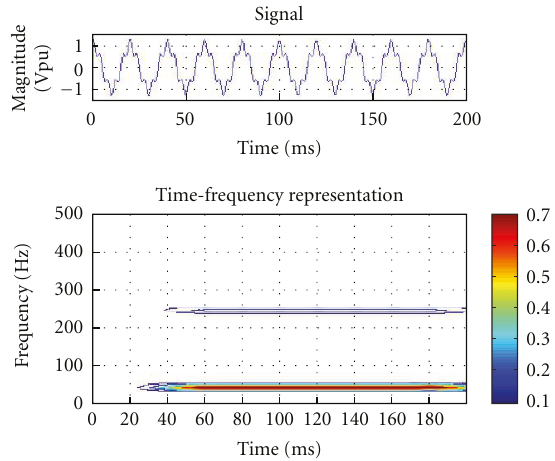
Figure 13: The TFR of harmonic signal using CWD at σ = 0 . 001.